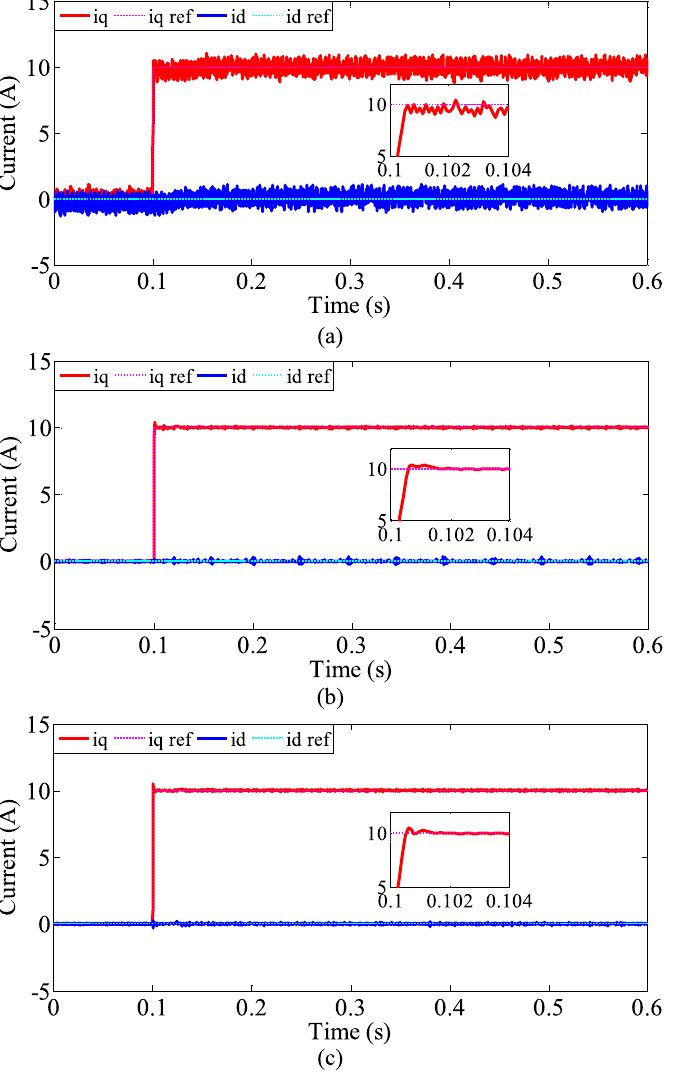
FIGURE 13. The dq -axes stator current response at 100rpm (experiment). axis stator currents response at 100 rpm. ( a ) FCS Figure 18. dq − (a) FCS-MPC. (b) FS-MMFPC. (c) MSL-MMFPC. ( c ) MSL −